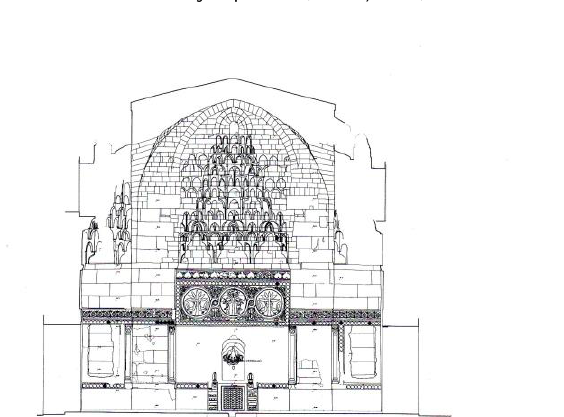
Figure 5. Hall of Fountain in the Zisa Palace (Monti, 1991).